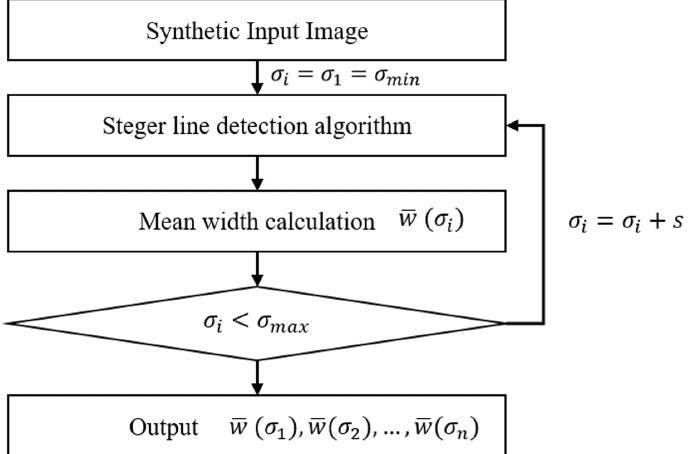
Figure 2. Procedure to identify the relationship between the line width ˆ w ( σ i ) and the σ parameter. A synthesized line is generated with known width and asymmetry. The line contrast h is known, so the upper and lower threshold parameters can be calculated analytically for each σ value according to the Equations (2) and (3). Starting from σ i = σ 1 = σ min , the Steger’s line detector algorithm is applied to the image. The mean width ¯ w ( σ i ) of the detected line is then stored. The mean width is calculated as the arithmetic mean of all widths calculated by the Steger algorithm at each of the m line points